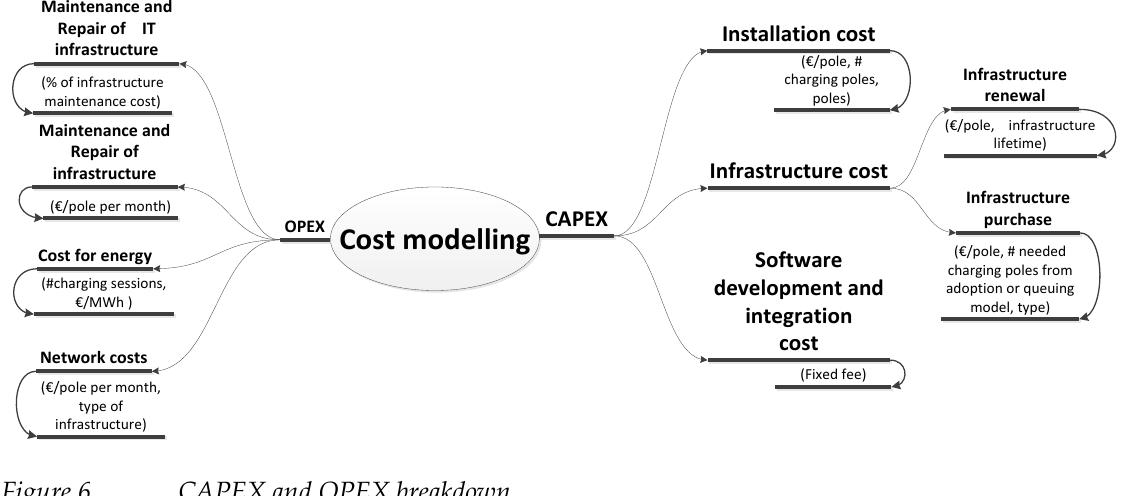
Figure 6. CAPEX and OPEX breakdown